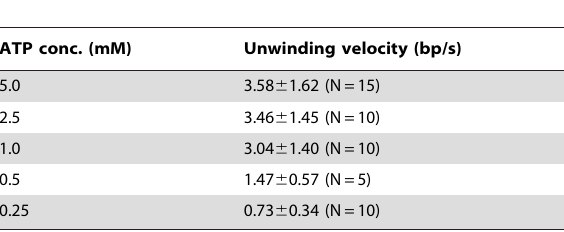
Table 1. ATP dependence of the unwinding velocity measured by